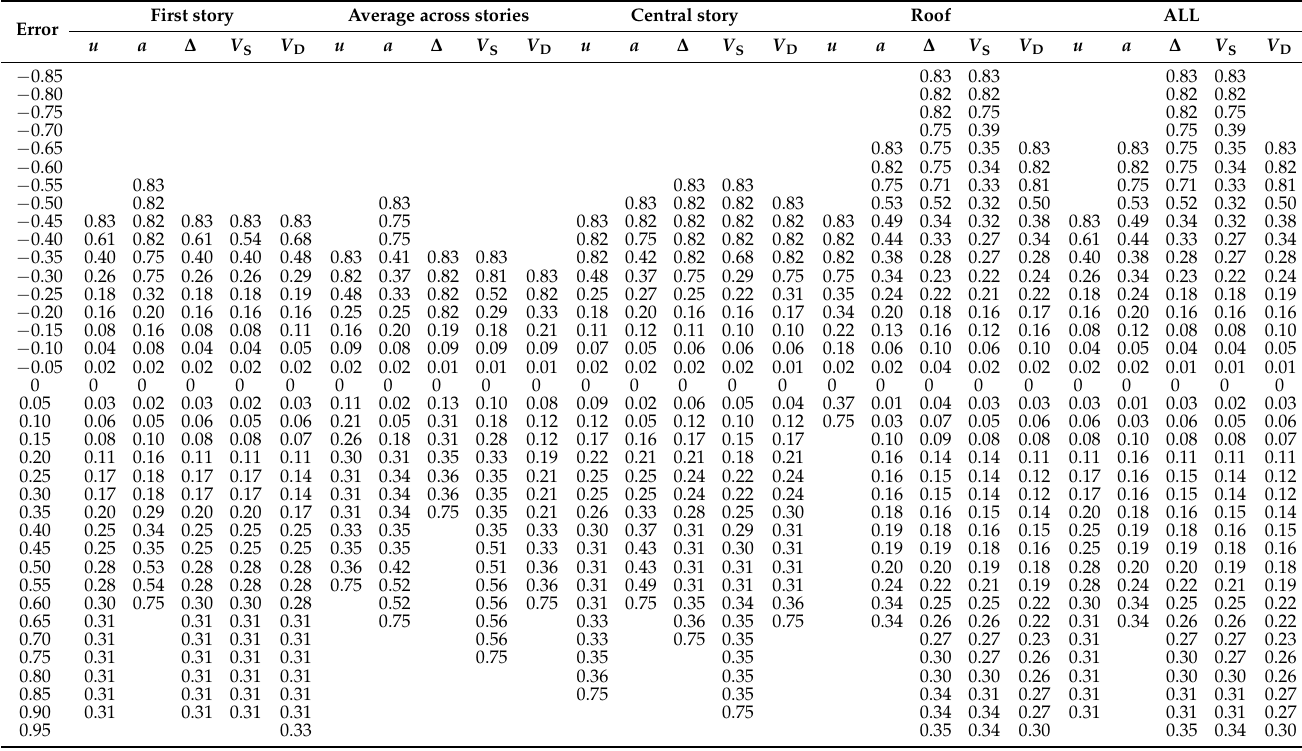
Table 9. Maximum value of I A 1 to limit the max and min THMA error (error